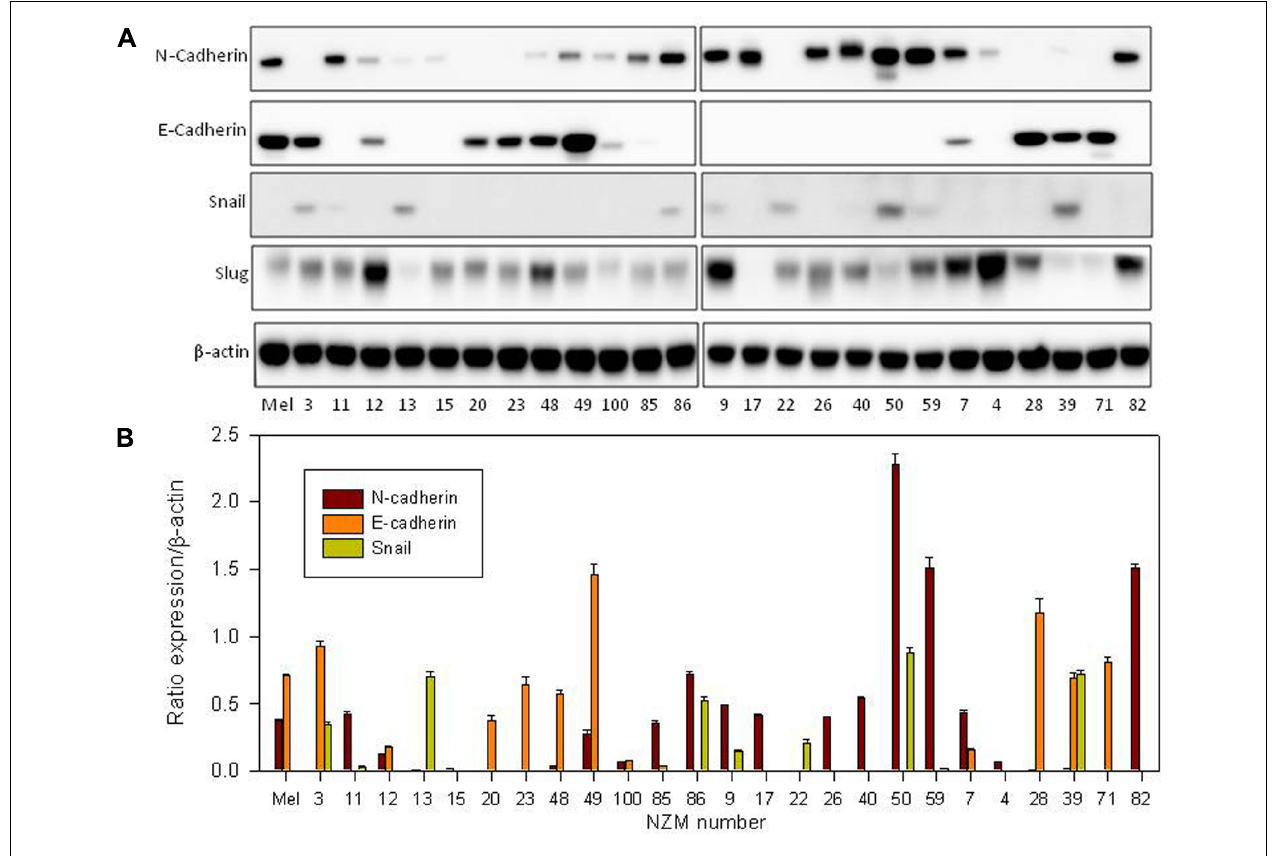
3 = NZM3); Mel indicates data for normal melanocytes.The western blot shown is representative of three independent repeats. (B) Western blot